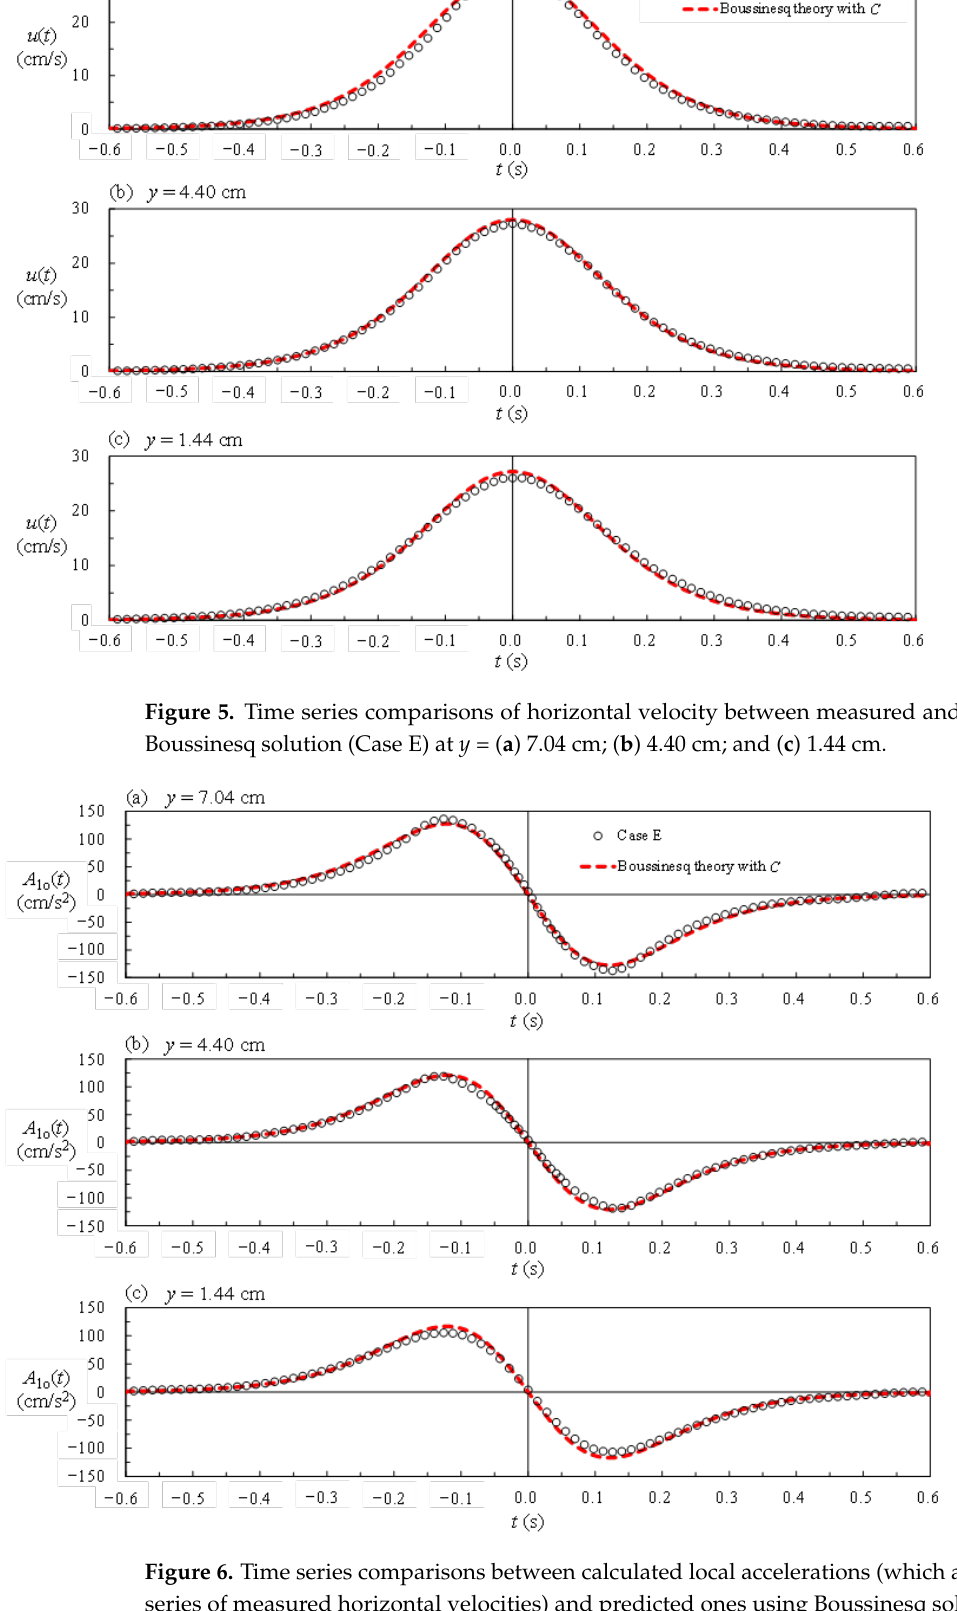
Figure 6. Time series comparisons between calculated local accelerations (which are based on time series of measured horizontal velocities) and predicted ones using Boussinesq solution (Case E) at y = ( a ) 7.04 cm; ( b ) 4.40 cm; and ( c ) 1.44 cm.